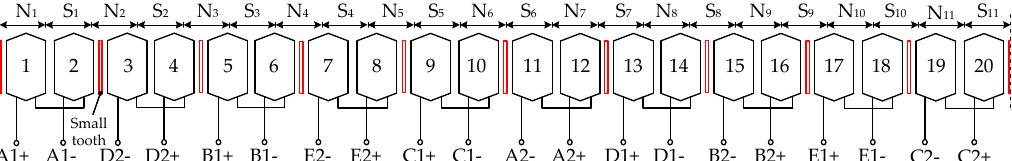
Figure 1. The cross-sectional diagram of the five-phase PMSM.